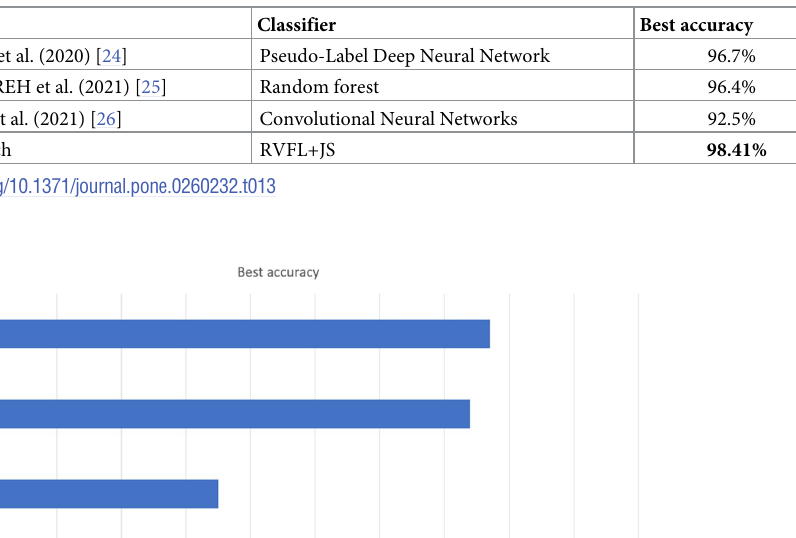
Table 13. Accuracy comparison of other works to the proposed model.